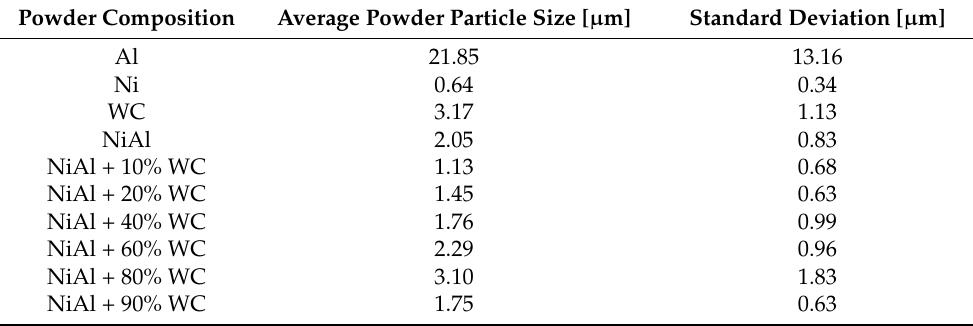
Figure 8. SEM microphotograph of NiAl-10WC ( a ), NiAl-20WC ( b ), NiAl-40WC ( c ), NiAl-60WC ( d ), NiAl-80WC ( e ) and NiAl-90WC ( f ) powders after 10 h of MA. Table 4. Average particle size of powders measured based on SEM microphotographs.